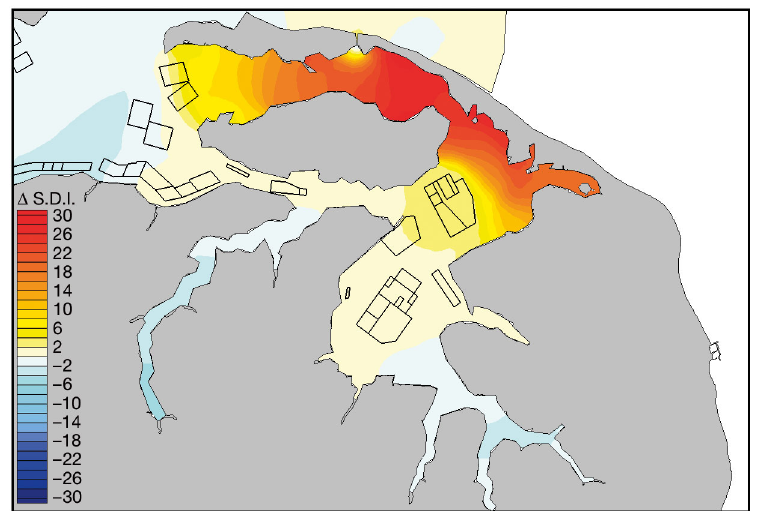
Fig. 8. Change in the seston depletion index (SDI) over the Baie du Village (BV) area due to the morphological alterations re- lated to the evolution of the breach in the sand barrier between 1999 and 2010. Mapped values ( Δ SDI) represent the differ- ence between 1999 and 2010 SDI estimates. Polygons indicate oyster